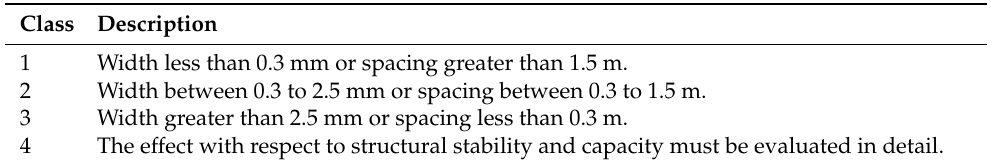
Table 3. Summary of important descriptions for the assessment of cracks in concrete roof slab and walls from guidelines by the Massachusetts Department of Transportation [73].